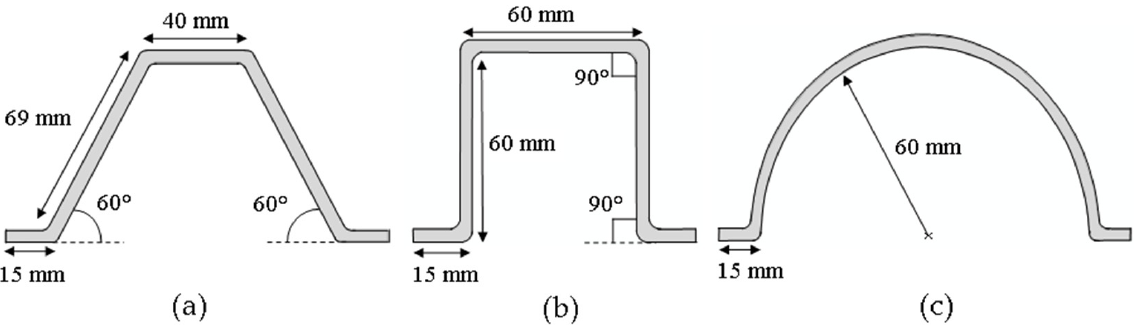
Figure 2. The frontal view of the self-supporting web specimens ( a ) 60° hat-shaped ( b ) 90° hat shape ( c ) half-sine hat shape.